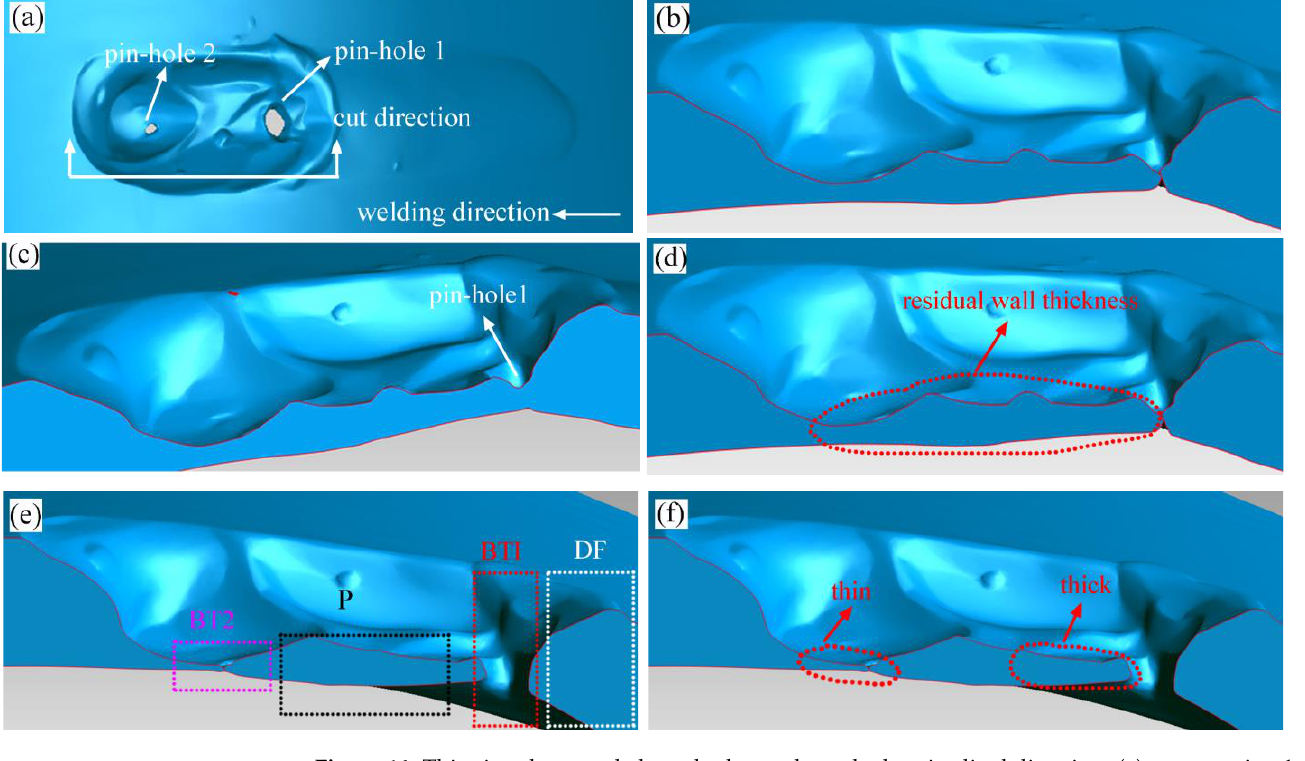
Figure 14. Thinning the sample layer by layer along the longitudinal direction. ( a ) cross section 1, ( b ) cross section 2, ( c ) cross section 3, ( d ) cross section 4, ( e ) cross section 5, ( f ) cross section 6.